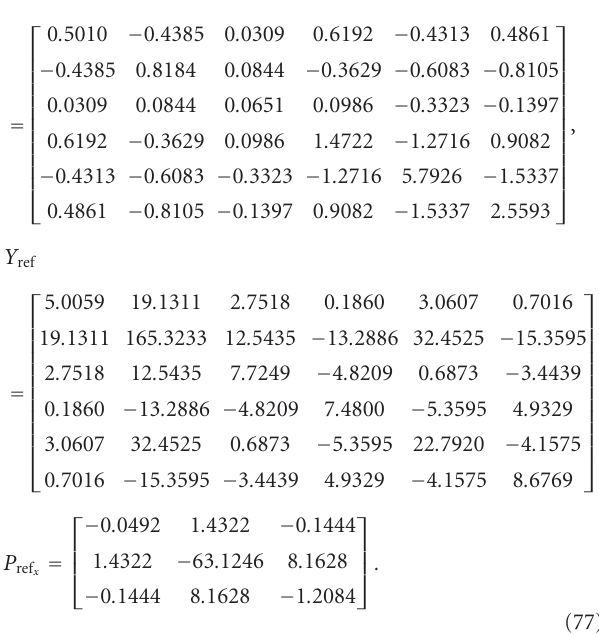
A square and diagonal structure for T ref is necessary to get fault isolation in the case that the faults occur at the same